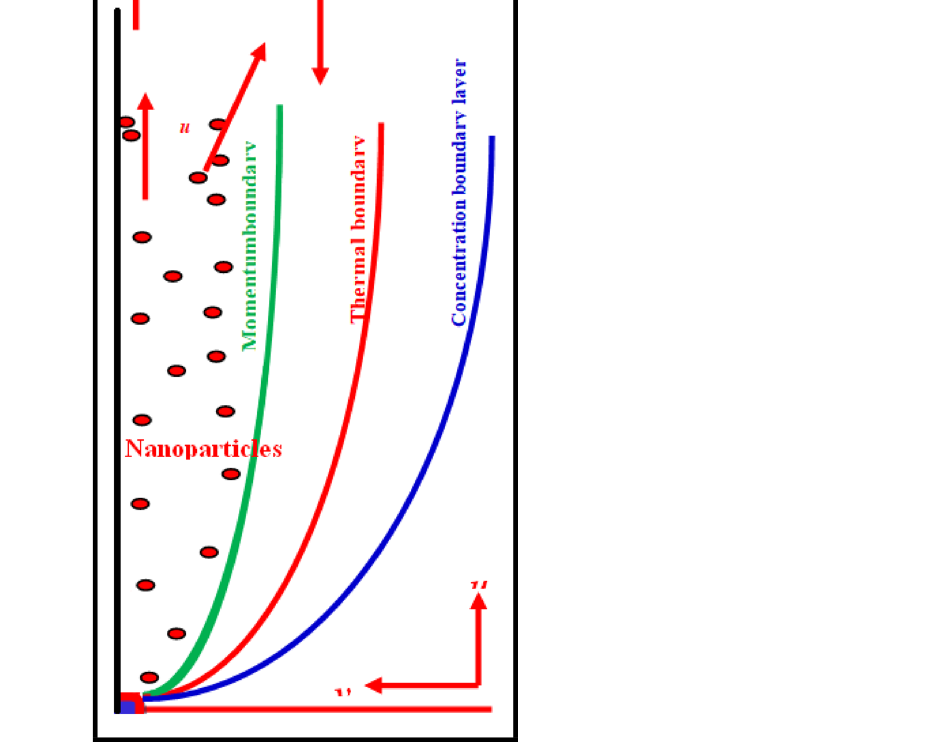
Figure 1. Physical description of the